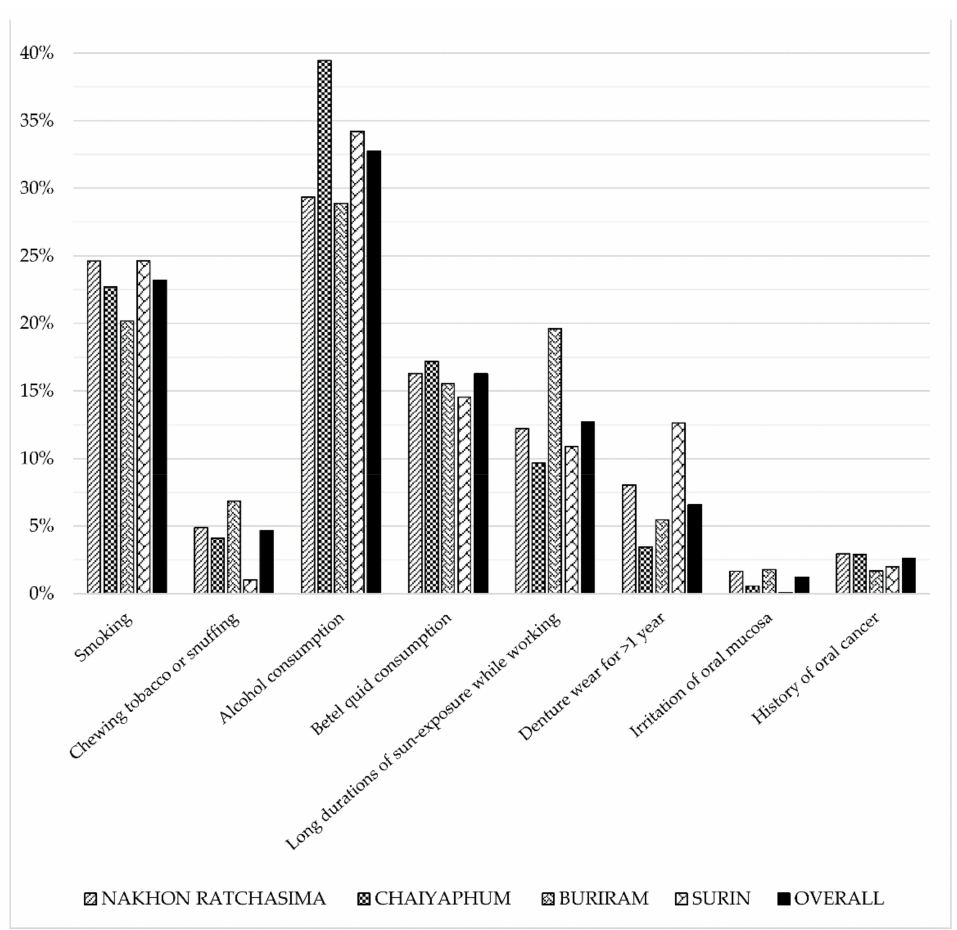
Figure 4. Prevalence of risk factors in individuals present at